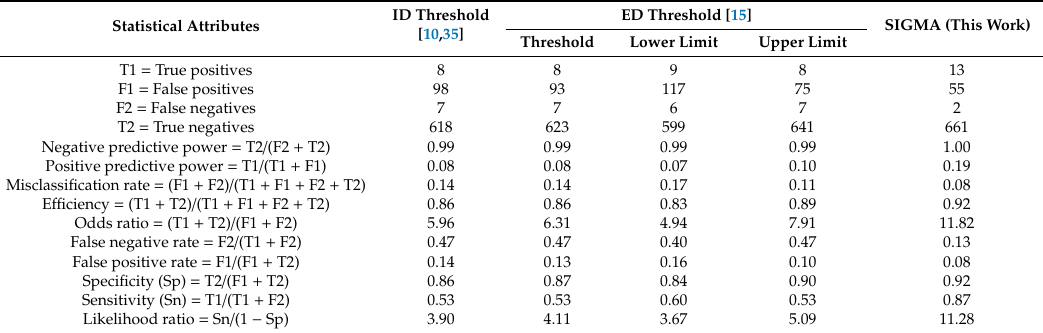
Table 3. Comparison of the SIGMA model with other empirical thresholds. Statistical